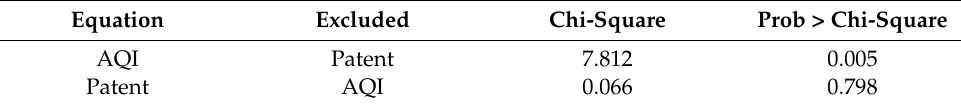
Table 4. Granger causality Wald